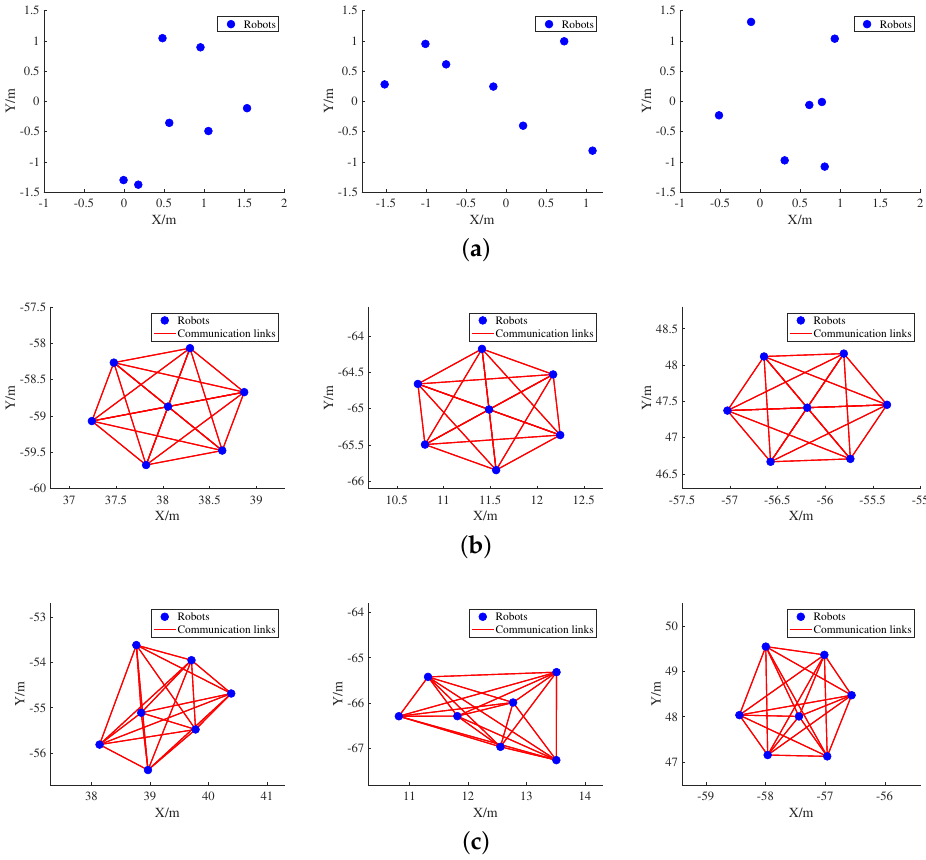
Figure 3. Variation of swarm morphology under the control of two expert strategies. ( a ) Three random initial forms of swarms. ( b ) The stable forms under the control of the APF strategy proposed in this paper. ( c ) The stable forms under the control of the APF strategy proposed in